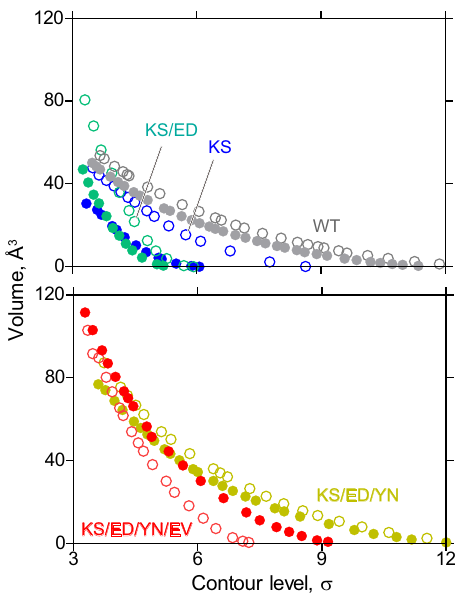
Fig. 4 Trends in the anomalous Rb + densities. Volumes of the Rb + anomalous densities (Å 3 ) observed at the periphery of the P domain (open symbols, black arrowheads in Fig. 2) and in the TM cation-binding site (closed symbols, red arrowheads in Fig. 2) for wild type and indicated mutants were plotted against their contour levels (in σ